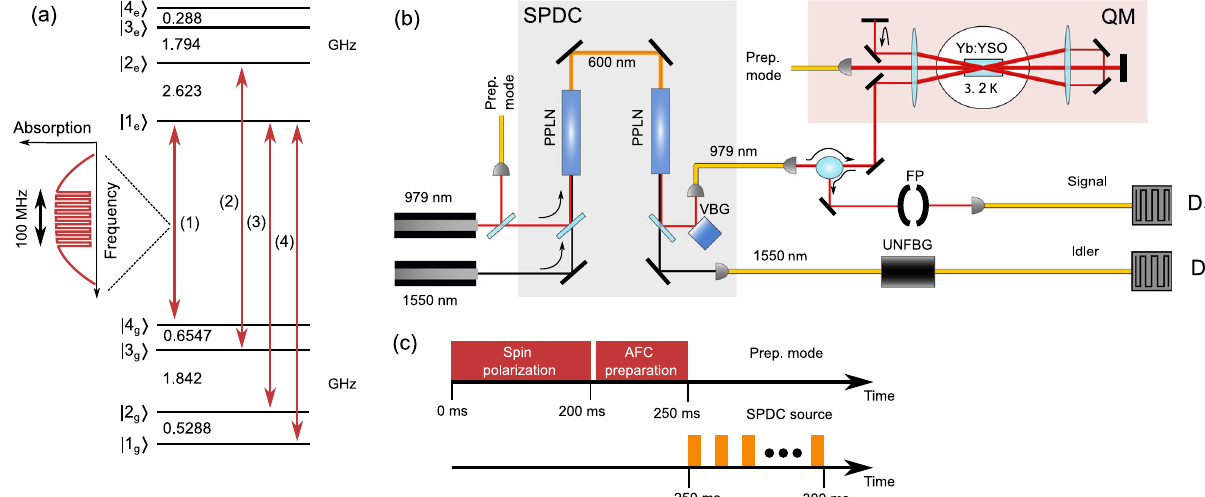
Fig. 1 | Experimental setup. a Energy level structure of 171 Yb 3+ :Y 2 SiO 5 at zero magnetic fi eldforsiteII.TheAFCquantummemoryiscreatedontransition(1)and transitions (2)-(4) were used for spin polarization into state ∣ 4 g i . b Conceptual experimental setup showing the main components of the SPDC source based on two periodically poled lithium niobate (PPLN) waveguides and the 171 Yb 3+ :Y 2 SiO 5 (Yb:YSO) quantum memory (QM), see main text and Methods for details. To increase absorption, the crystal is mounted in a quadruple-pass con fi guration, where the backward979 nm output modeisseparated fromthe input modeviaan